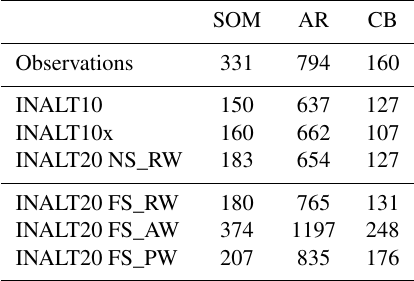
Table 4. Mean (2000–2009) SSH variance (in cm 2 ) in the three dif- ferent regions indicated in Fig. 3f: southwest of Madagascar (SOM), Agulhas retroflection (AR) and Cape Basin (CB). See Fig. 5 for cor- responding anomaly time series. SOM AR